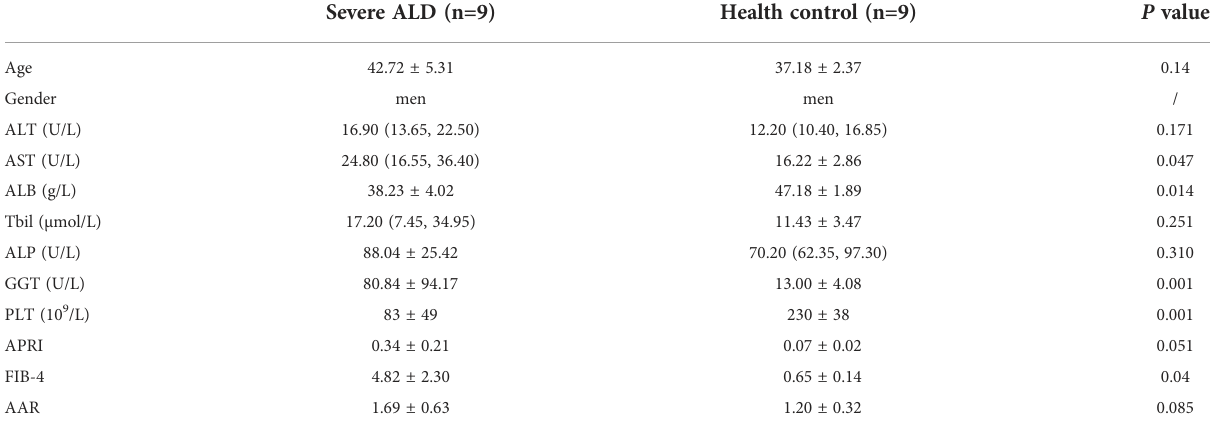
TABLE 2 Clinical characteristics of participants in the discovery